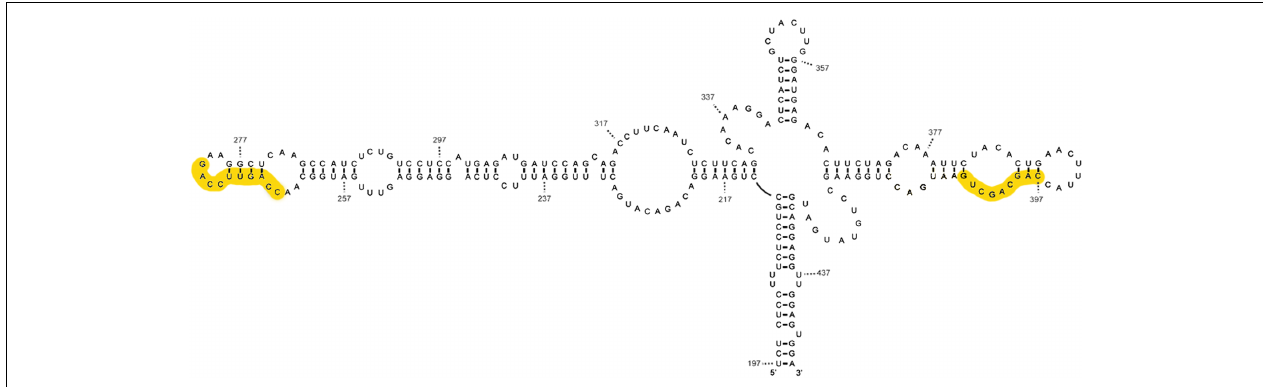
FIGURE 3 | Mimetic structure of the tRNA-like of IFN5A. This image shows the secondary structure of the tRNA-type element of alpha interferon mRNA subtype 5 determined by various chemical and enzymatic methods. The CAR-E sequences are highlighted in